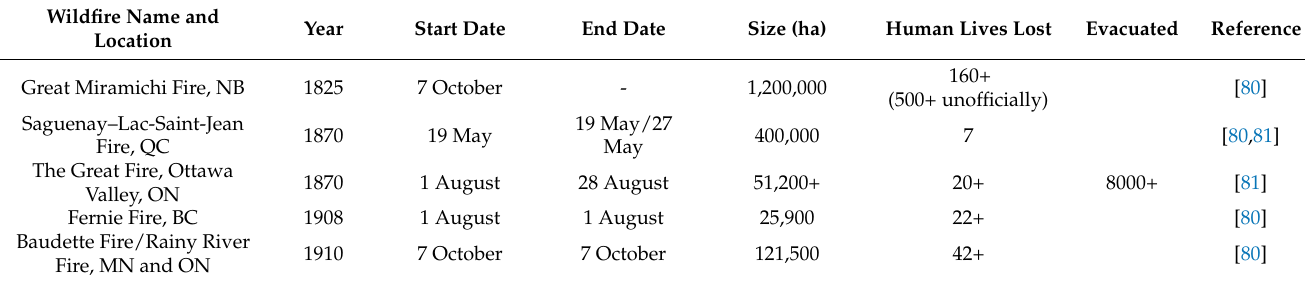
Figure A2. Historical seasonality of extreme crown fire behavior in Canada for 1825–2017 compared with seasonal trend of live fuel flammability measured in 2014 and that assumed by the FBP model. The FPB model represents live fuel flammability expressed as a FMC-derived Crown Spread Factor (dashed line) at a rough temporal scale assuming only one seasonal maximum in live fuel flamma- bility around 1 June. Live fuel flammability measured in our study as differential effective heat of combustion ∂ H eff for 2014 (solid line) showed seasonal trend of higher temporal resolution with three seasonal maximums that match the maximums in historical seasonality of extreme crown fire behavior (gray histogram representing number of extreme fires started during a given 5-day period) according to the dataset in Table A1: early May (three weeks earlier compared with the assumptions of the FBP), early July, and early August. By contrast, the Crown Spread Factor by the FBP model assumes close to the lowest values for the season in early July and early August. Table A1. List of extreme wildfires in Canada for 1825–2017. Data from the list were used to build a histogram of historical seasonality of extreme crown fire behavior in Canada for 1825–2017 in Figure A2. When the information differed between two referenced sources, data from both were reported, separated by a slash